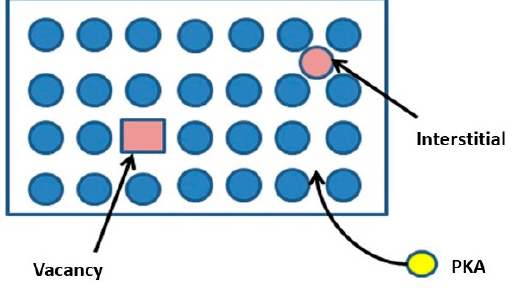
Figure 7. Frenkel pairs.